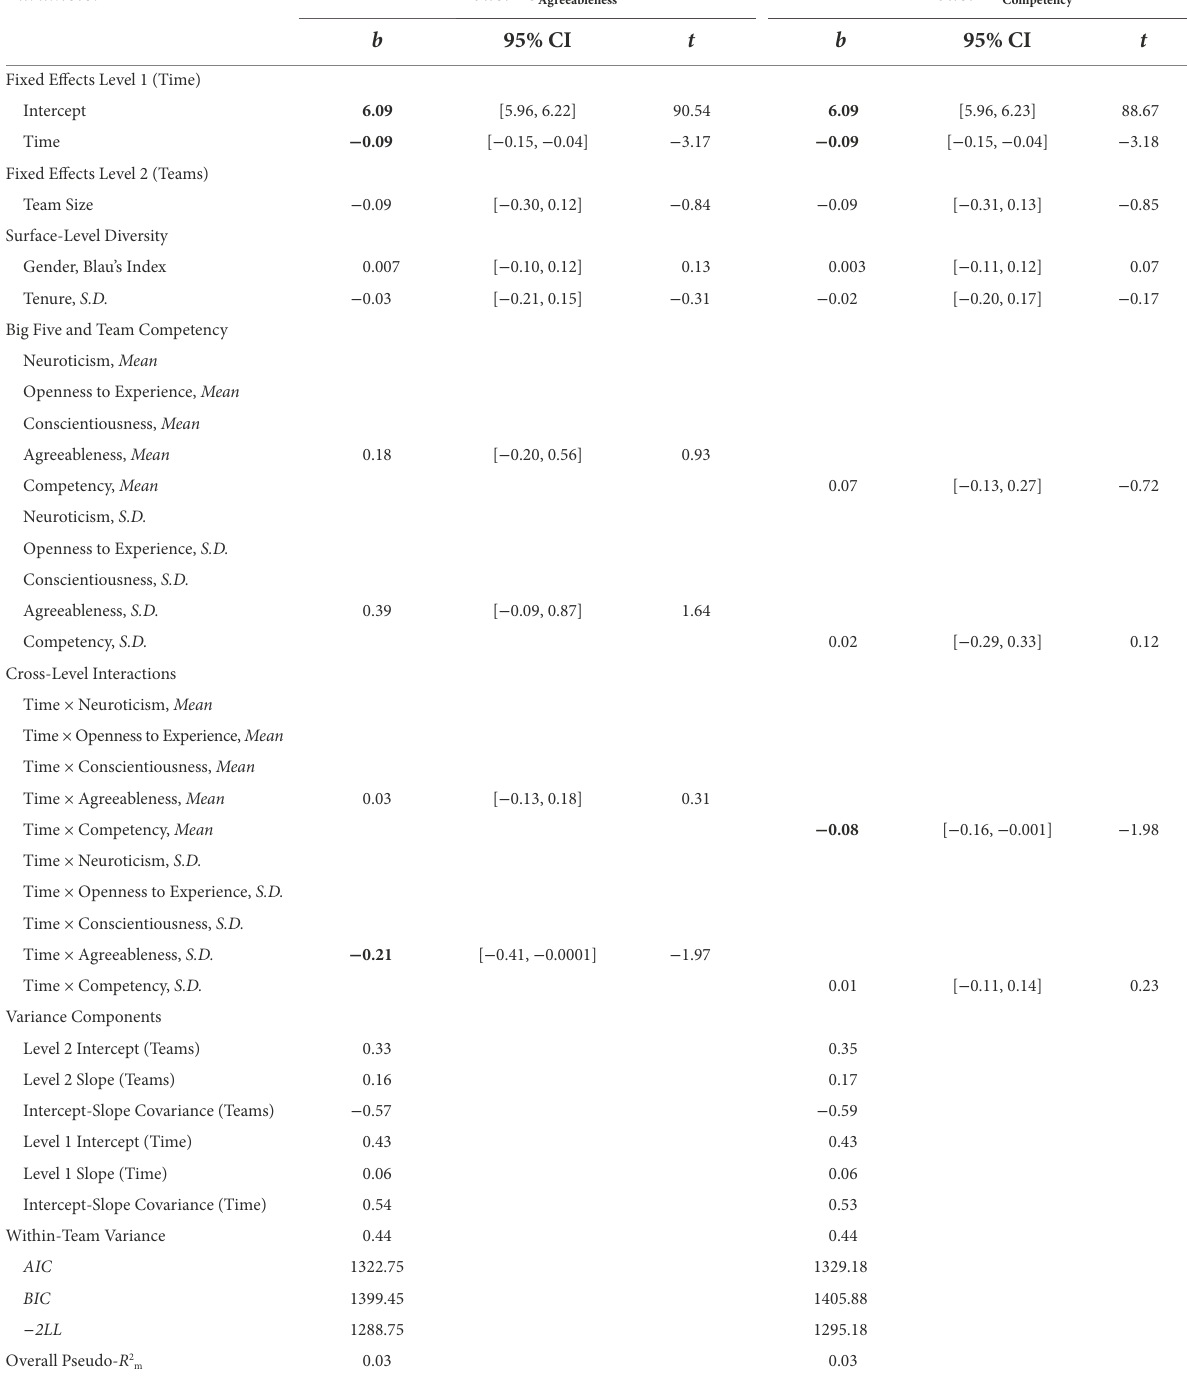
Table 5 Linear Growth Curve Model ( n = 699 measurements nested in three time points, in 233 members in 61 teams) for changes in team psychological safety predicted by team personality and competency (Models 10 and 11).